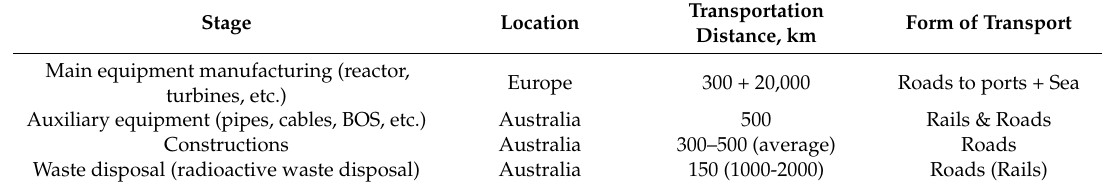
Table 2. Transport distances adopted by the study.